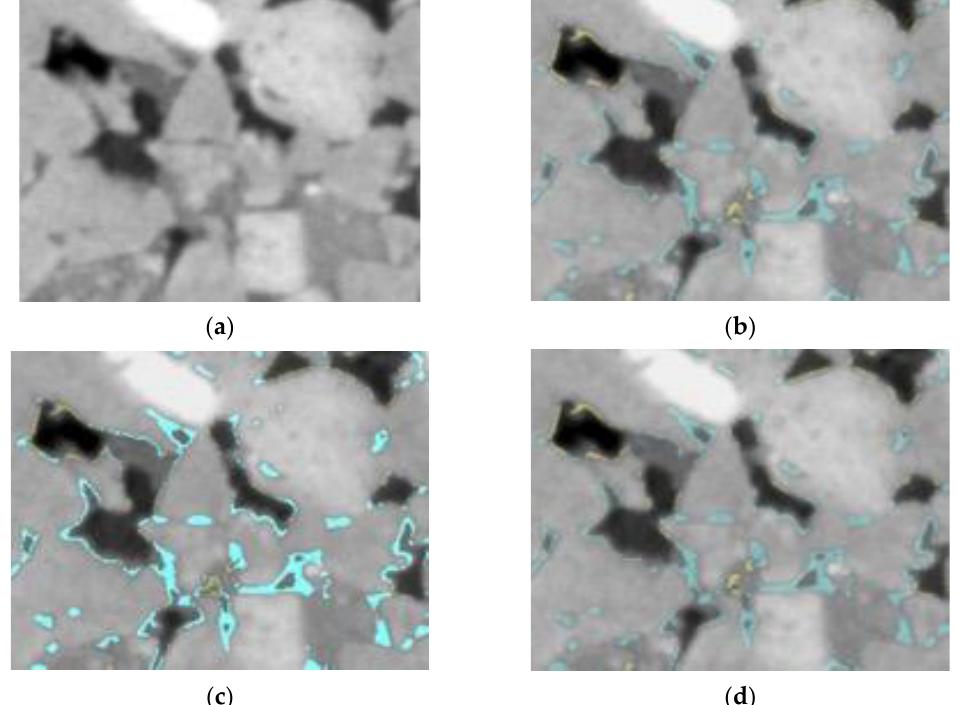
Figure 5. Impact and comparison at the local scale of the bilateral, Anisotropic Diffusion and Non-Local Means filters with Otsu’s thresholding compared to Ilastik: ( a ) the raw reconstructed image with ( b ) the bilateral filter, ( c ) Anisotropic Diffusion, and ( d ) Non-Local Means. Local zooms with the voxels corresponding to voxels considered to represent porosity with Ilastik only (relative to the cited filter + Otsu’s thresholding) in cyan; with the voxels corresponding to voxels considered to represent porosity with the cited filter + Otsu’s thresholding only (relative to Ilastik) in